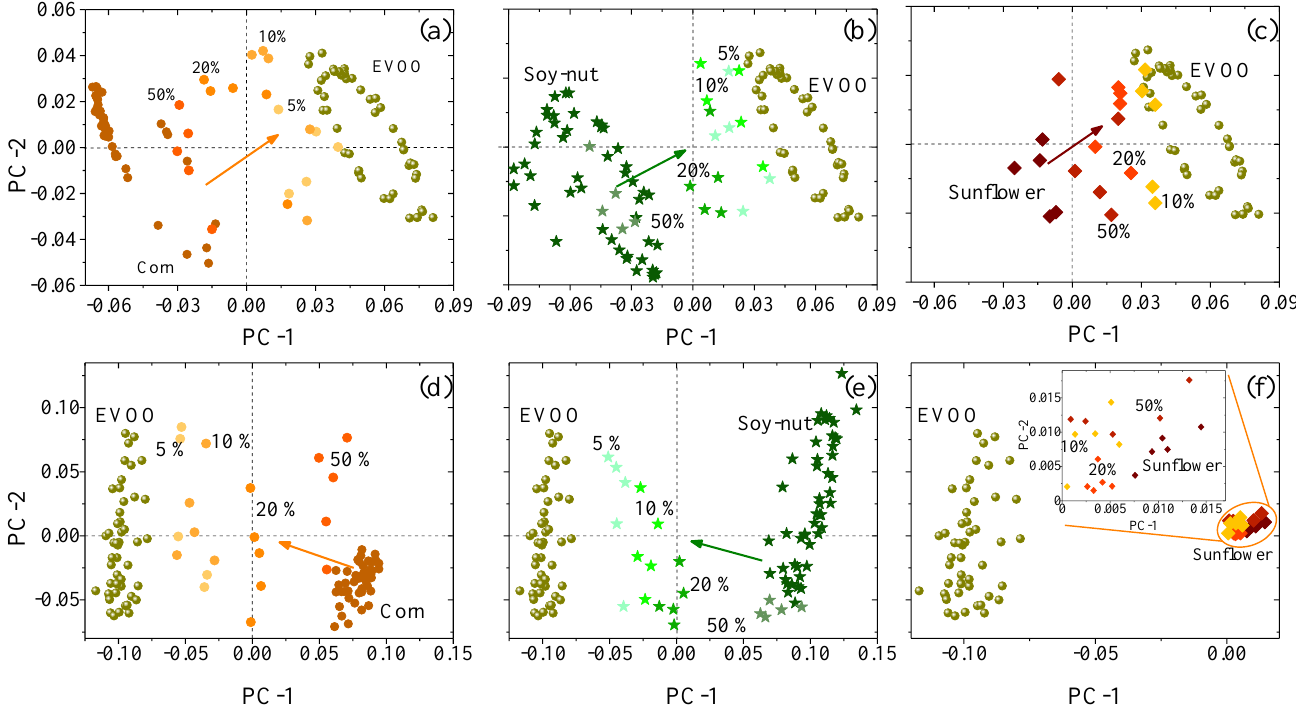
Figure 5. PCA score plots of oil mixtures at the 3000 cm − 1 and 1300 cm − 1 window: ( a , d ) corn–EVOO, ( b , e ) soy–nut–EVOO, and ( c , f ) sunflower–EVOO. The inset in ( f ) shows a zoom around the PCA scores of the sunflower-based sample. The color gradient in each figure indicates the evolution of the PCs from pure adulterant (darker colors) to smallest amount of adulterant (lighter colors).